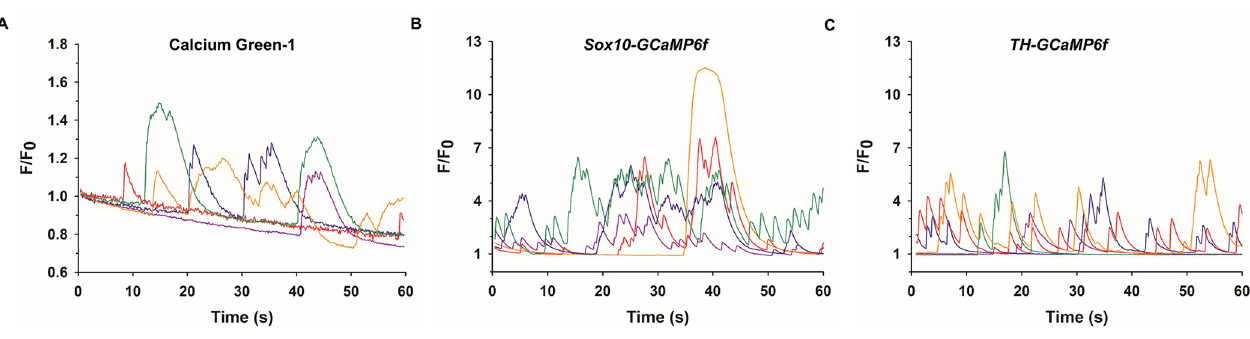
Fig 3. Comparison of spontaneous fluctuations in [Ca 2+ ] i in Calcium Green-1 loaded and GCaMP6f-expressing ACC. Representative fluorescence traces of spontaneous Ca 2+ activity in (A) Calcium Green-loaded ACC, (B) ACC derived from Sox10-GCaMP6f mice or (C) from TH-GCaMP6f mice. In (A), traces are from ACC in different dishes from the same mouse. In (B) and (C), traces are from ACC from 3 different mice from different litters. In (A), photobleaching is evident by the drop in fluorescence intensity below F/F 0 = 1.